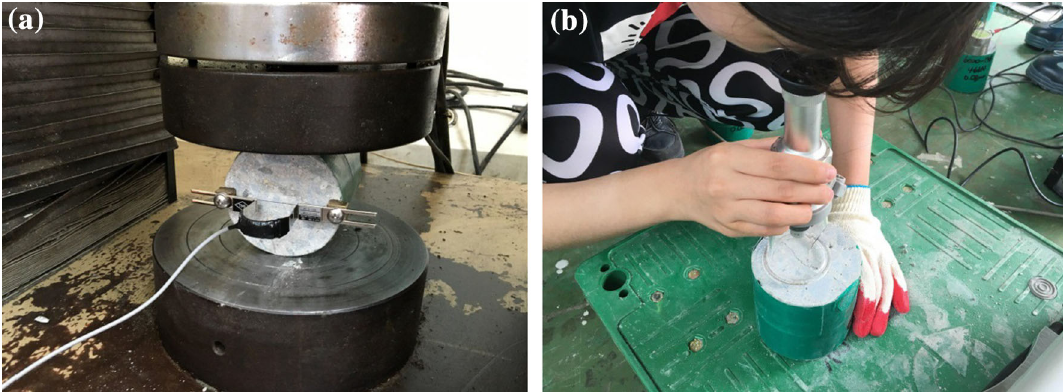
Fig. 1 Photographs for crack inducing and crack measurement. a Crack inducing and gauge setup. b Crack width measurement.